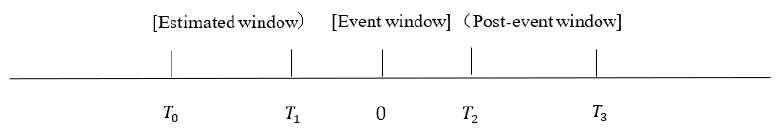
Figure 1. Event Study Method .